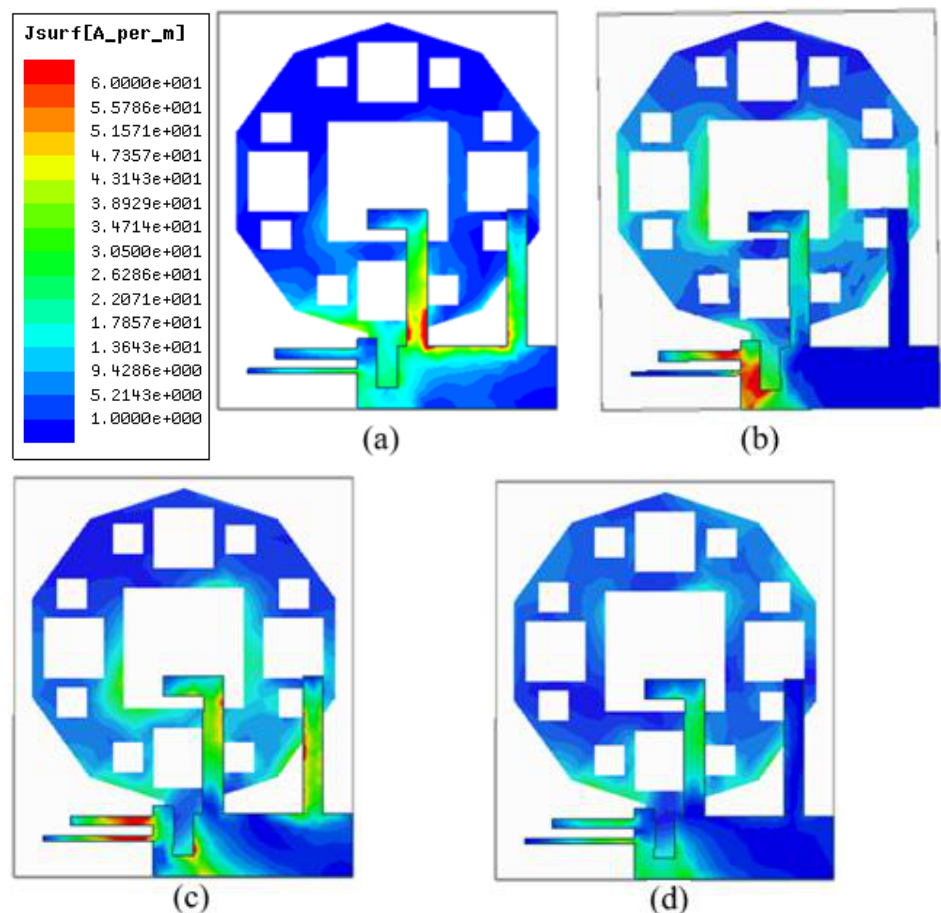
Figure 24. Surface current at ( a ) 4.85 GHz, ( b ) 7.65 GHz, ( c ) 9.1 GHz, ( d ) 11.1 GHz.